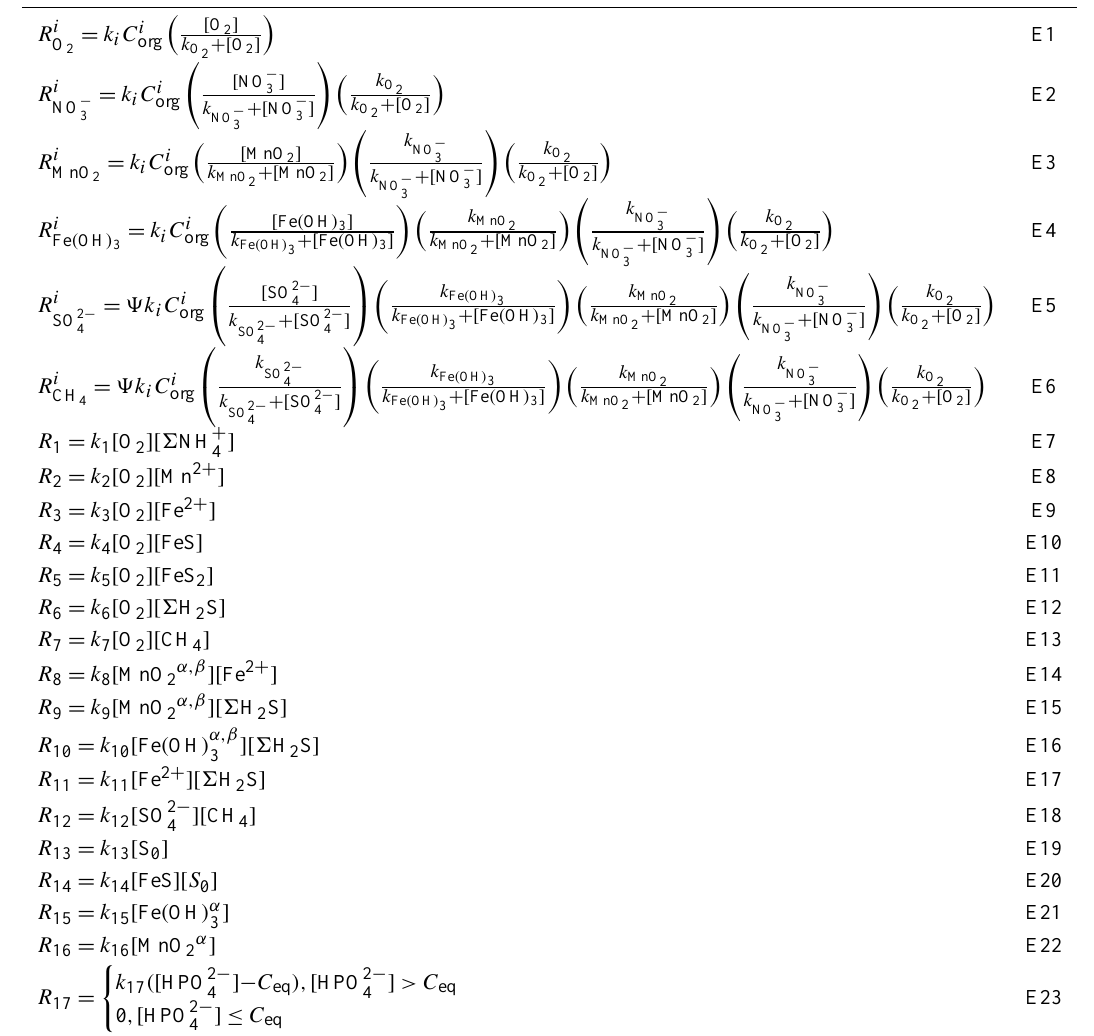
Table 5. Primary and secondary redox reaction equations after Reed et al. (2011b). Superscript and subscript i denote the type of organic matter ( α , β , γ : see text for